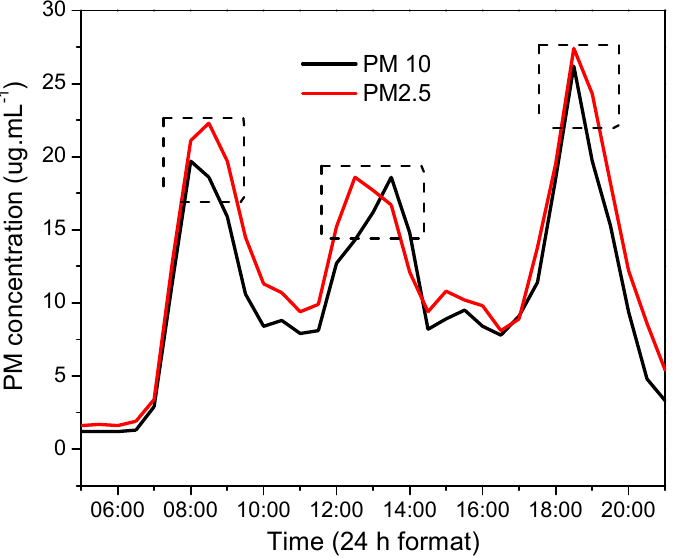
Figure 4. PM2.5 and PM10 average concentrations (from 5:00 to 21:00) considering records from all sensors over the 4 ‐ week period. Weekend data were not considered.